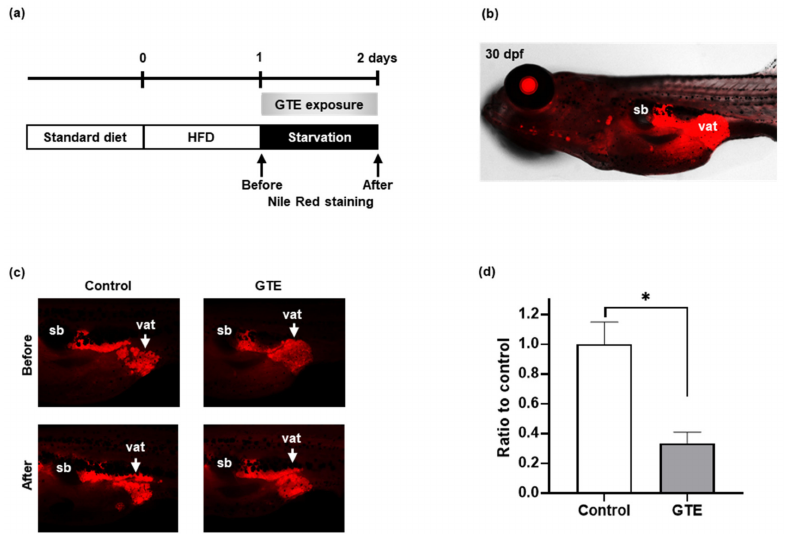
Figure 1. Green tea extract (GTE) suppressed lipid accumulation in zebrafish larvae. Live zebrafish at 30 dpf (day post fertilization) with a standard length of approximately 10 mm were used. ( a ) Experimental design of the zebrafish obesogenic (ZO) test. ( b ) Lateral view under a fluorescence microscope after Nile Red staining. vat, visceral adipose tissue (VAT); sb, swim bladder. ( c ) Representative VATs from live larva were selected after Nile Red staining, and images were recorded before and after 24 h of exposure or not to GTE (100 µ g / mL). Nile Red-positive areas indicate VAT (red). ( d ) Quantification of the intensity of Nile Red positive staining. GTE reduced the amount of VAT compared to that in animals on a high fat diet (control). The Y axis indicates the ratio of Nile Red staining before and after GTE treatment for 24 h. * p < 0.05 vs. control, n = 5, error bars indicate SD.